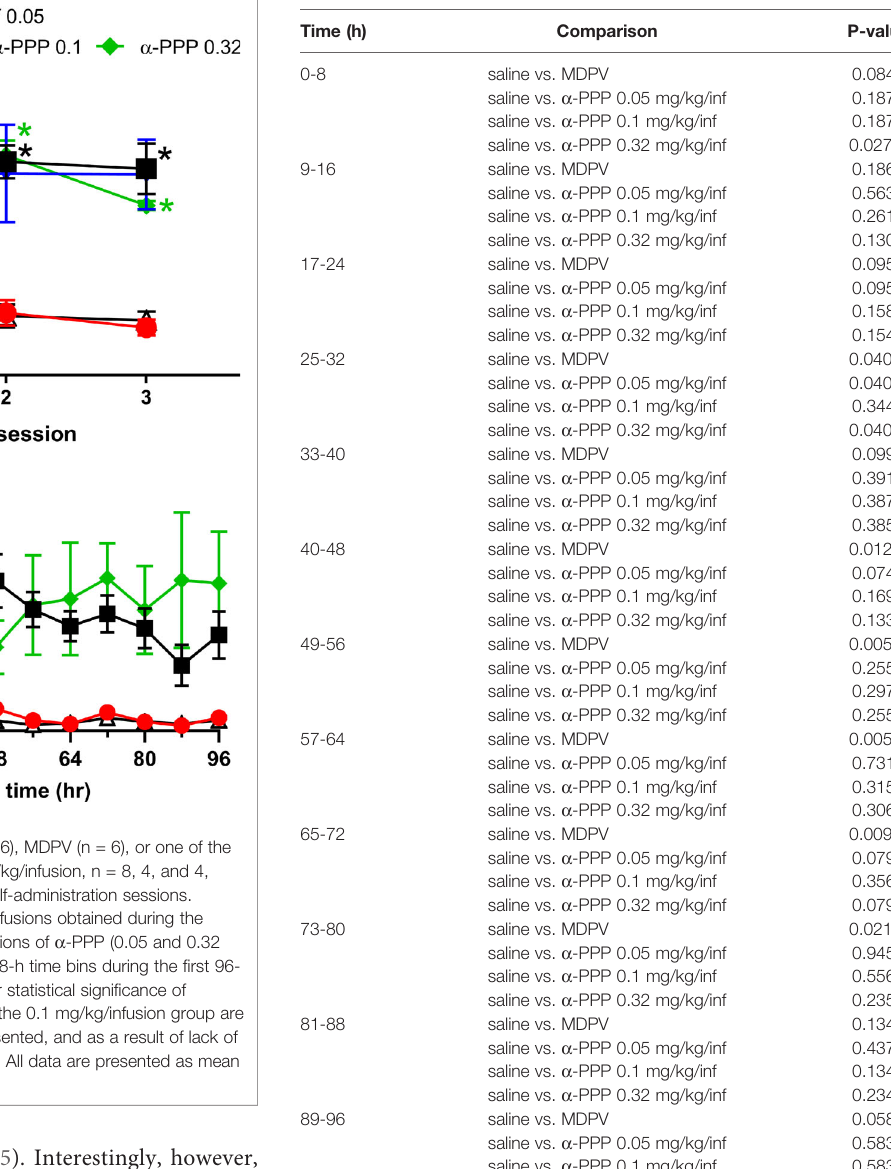
TABLE 1 | Analysis of 8-h time bins for self-administration of MDPV or one of three doses of a -PPP vs. saline during the fi rst 96-h session.